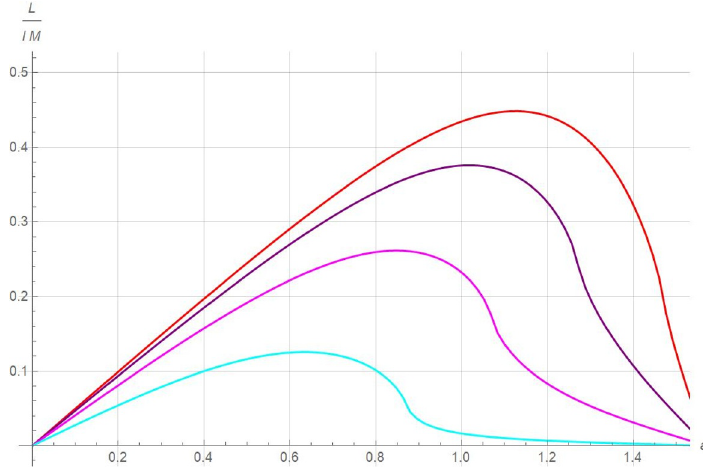
Figure 2 . We plot the normalized L/Ml as a function of the parameter a and find that it is everywhere smaller than 1 , demonstrating (1.2). The colors are as in figure 1. It is clear that smaller b give higher maxima and for b = 0 we are back at the GKP-like